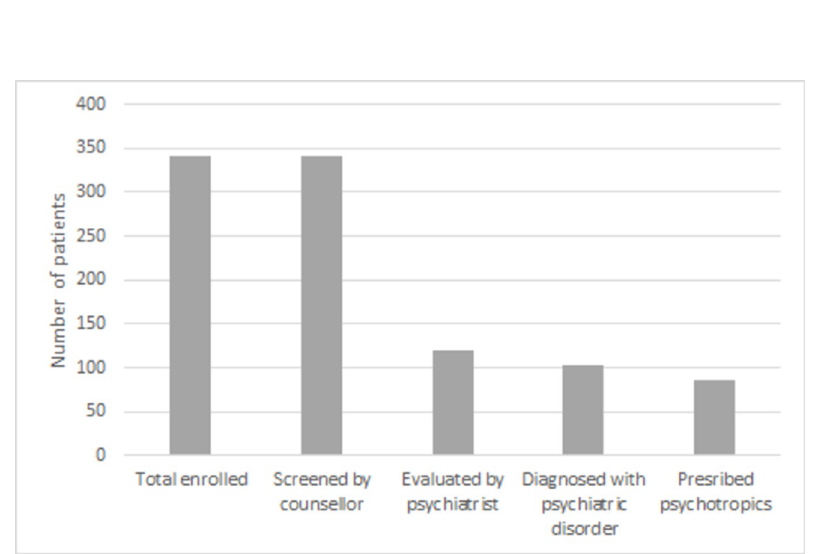
Fig 1. Cascade of psychiatric care among drug-resistant tuberculosis patients enrolled at Me´decins Sans Fronti è res Mumbai clinic between January 2012 and March